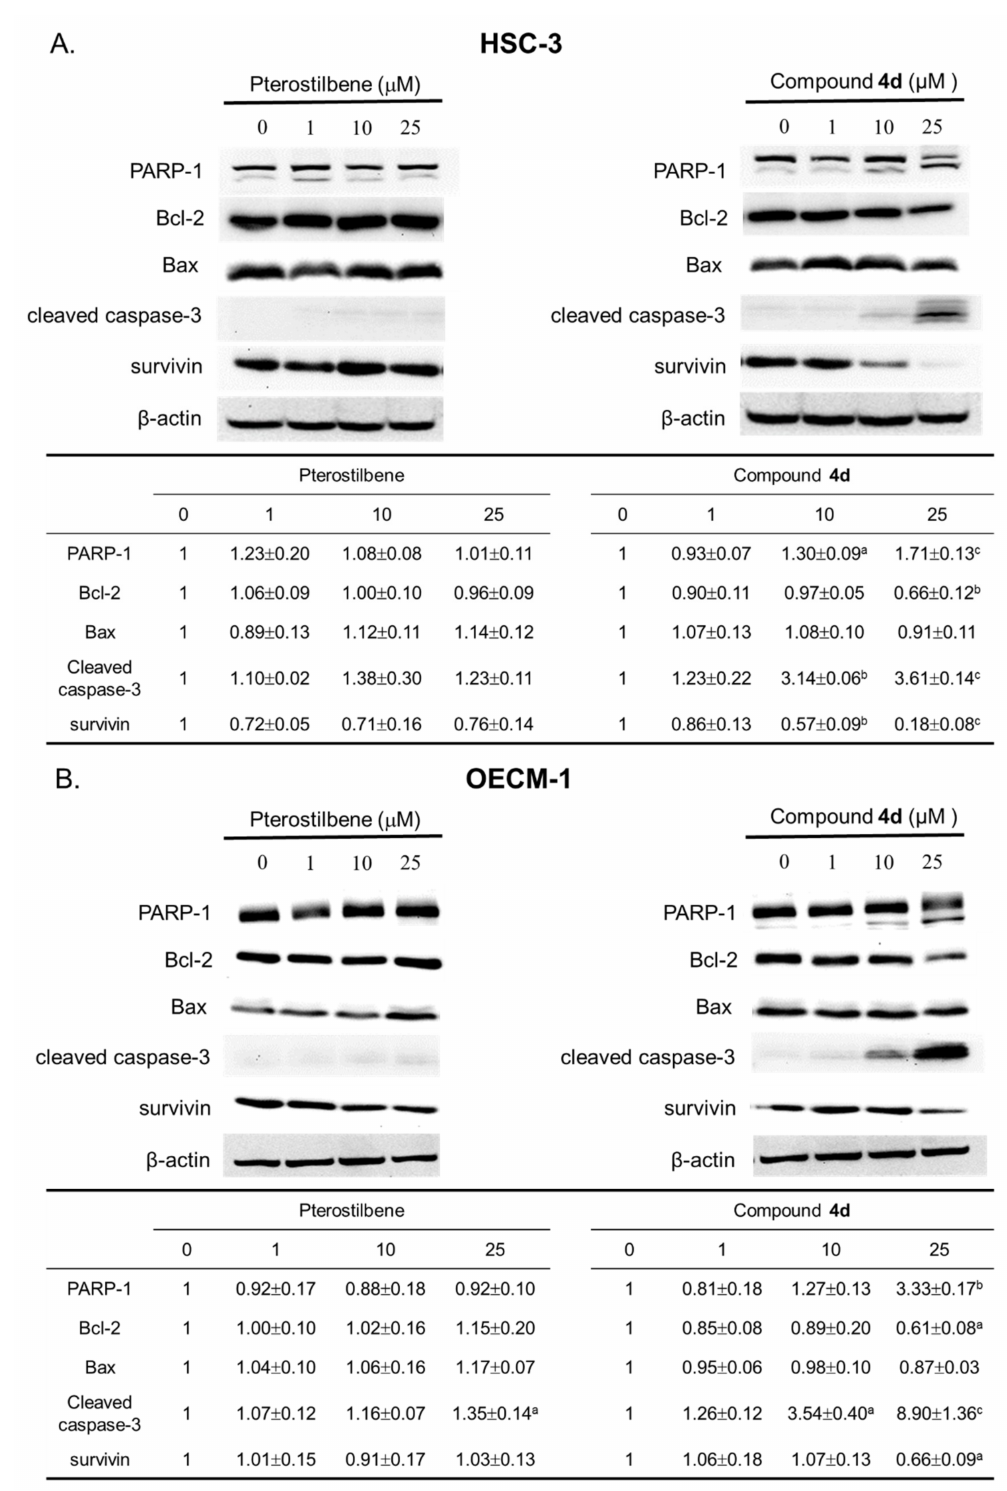
Figure 8. Cell apoptosis induced by compound 4d through modulation of apoptosis-related proteins. For the analysis of apoptosis-associated protein expression, ( A ) HSC-3 and ( B ) OECM-1 cells were treated by compound 4d or Pterostilbene with 0 (DMSO control), 1, 10, and 25 µ M. 24 h later, the cells were harvested, lysed, and the protein was isolated. Protein expression of cleaved PARP, bcl-2, Bax, cleaved caspase 3, survivn and β -actin was evaluated by Western blot using corresponding antibodies. The data were quantitative and indicated as follows: a p < 0.05; b p < 0.01; c p < 0.001 between each group and vehicle